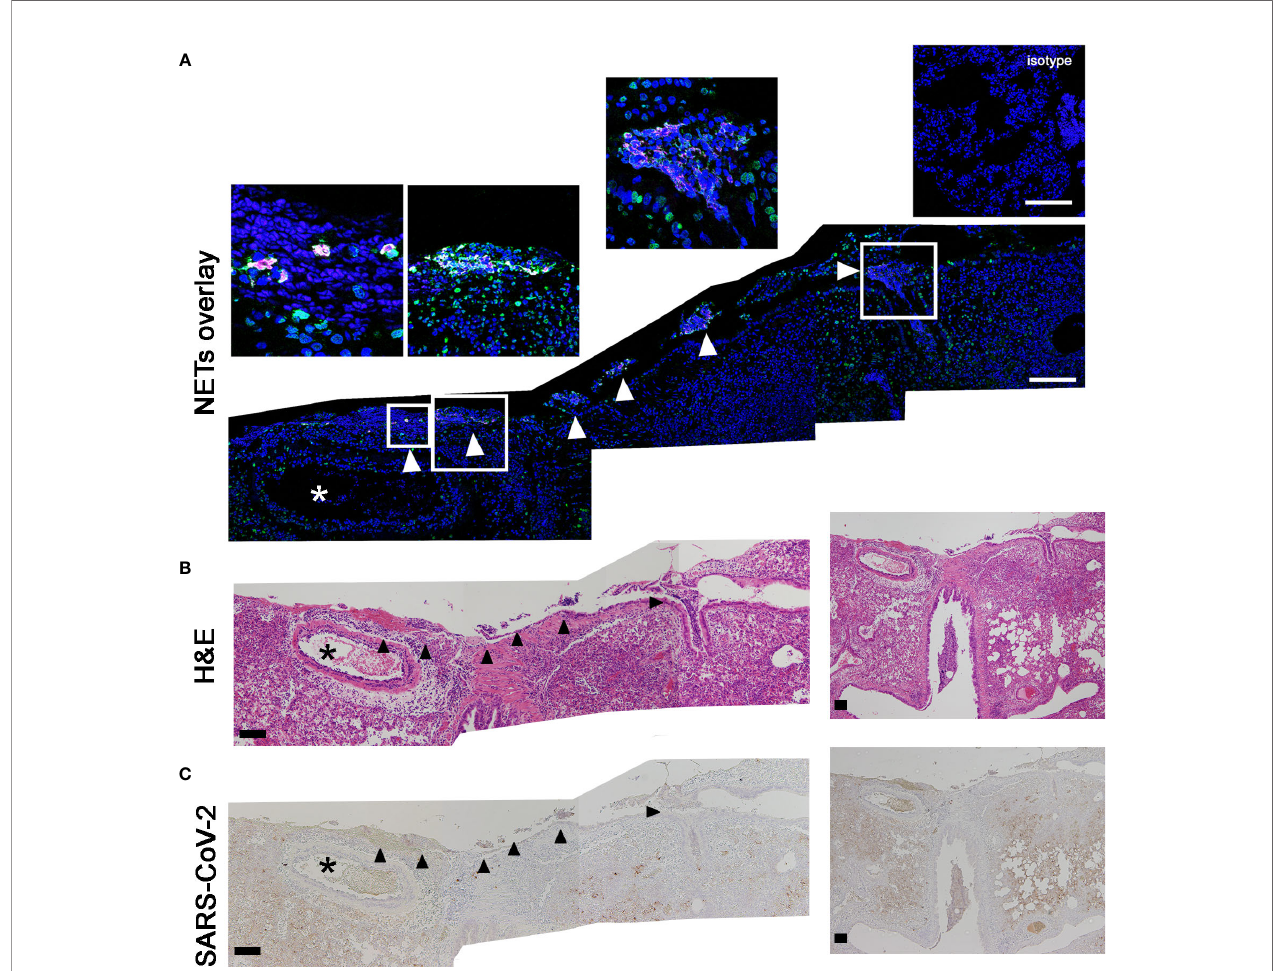
FIGURE 4 | H3cit positive NET structures are found close to vessels with vasculopathy and SARS-CoV-2 protein. (A) The staining of citrullinated histones (H3cit = magenta) and DNA-histon-1-complexes (green) as NET-marker was conducted. The DNA is stained in blue. (B) The two following serial cuts were stained for H&E and (C) virus antigen (dark brown coloration). Events of NETs are detected inside of broncholi (arrow heads). Blood vessel (asterisk) with vasculitis were found close to NET positive areas. Scale bars: all stitched images (A – C) = 100 µm. Settings of the immuno fl uorescence microscope were adjusted to a respective isotype